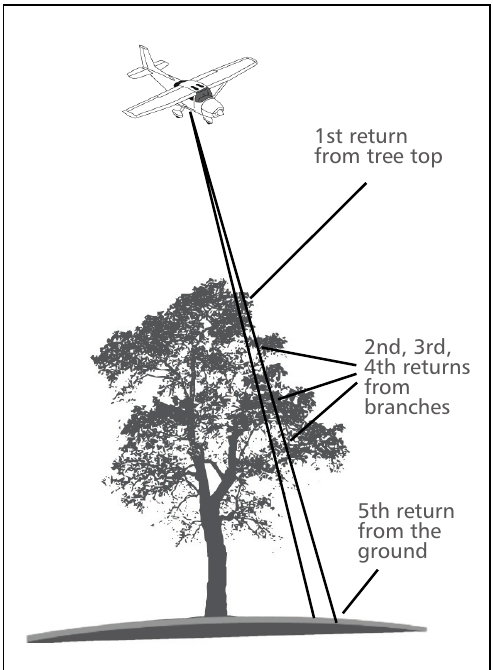
FIGURE 2. Multiple returns from a single laser pulse [26]